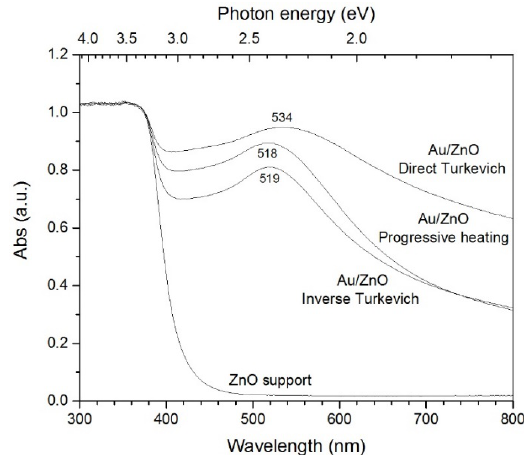
Figure 4. Diffuse reflectance spectra (shown as absorbance) of the ZnO support and those Au- NPs/ZnO samples obtained through different impregnation methods. samples obtained through different impregnation